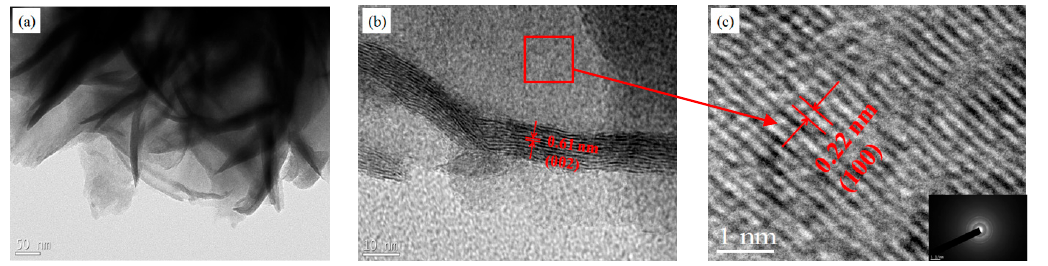
Figure 5. TEM image of Si/MoS 2 composite ( a ); high-resolution TEM images ( b ) and ( c ). Figure 5a is the transmission electron microscope (TEM, Tecnai F30G2, FEI, Hillsboro, USA) image of Si/MoS 2. It confirms the microflower structure further, in which many nanosheets are stacked on each other. The result is consistent with the SEM image in Figure 3f. Figure 5b is a high- resolution-TEM image of Si/MoS 2 , in which it is clearly observable the ordered lattice fringes with the